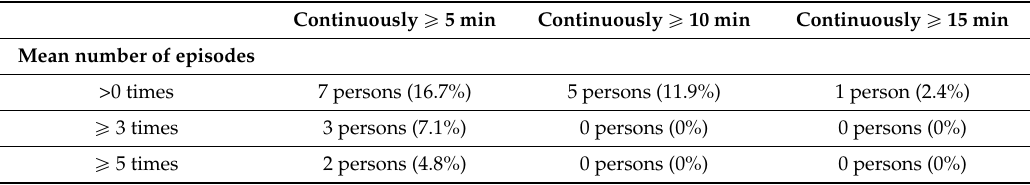
Table 2. Participants experiencing continuous episodes of relative heart rate above 33% during work.